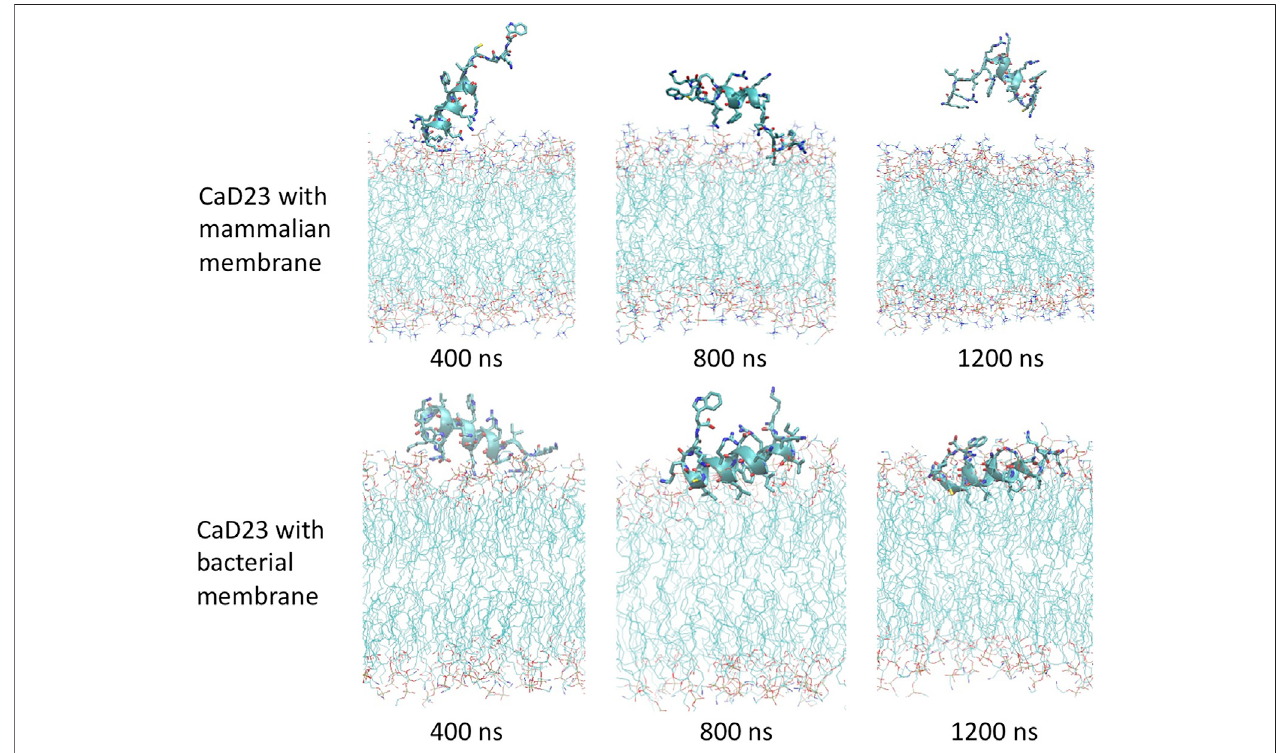
FIGURE 4 | Molecular dynamics simulations study visualising the interaction between CaD23 and mammalian/bacterial membranes at an atomistic level. RepresentativesnapshotsofCaD23withmammalianandbacterialmembranes.Theconformationofeach snapshot corresponds tothemost commoncon fi gurationof CaD23 during the last 400 ns simulations. The snapshots demonstrate a stronger interaction (a closer distance) between CaD23 and bacterial membrane than mammalian membrane, corresponding with the experimental data on ef fi cacy (high) and toxicity (low). This also suggests that the rapid action of CaD23 is likely attributed to its membrane-permeabilising action.